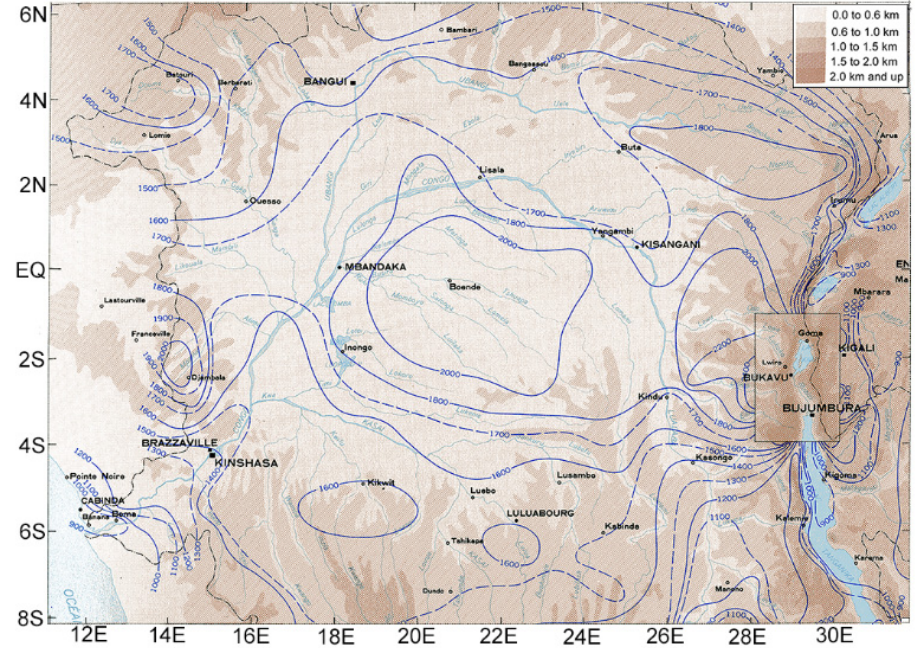
Figure 3. Mean annual rainfall over the Congo region based on an extensive gauge data set (adapted from Bultot, [64]).